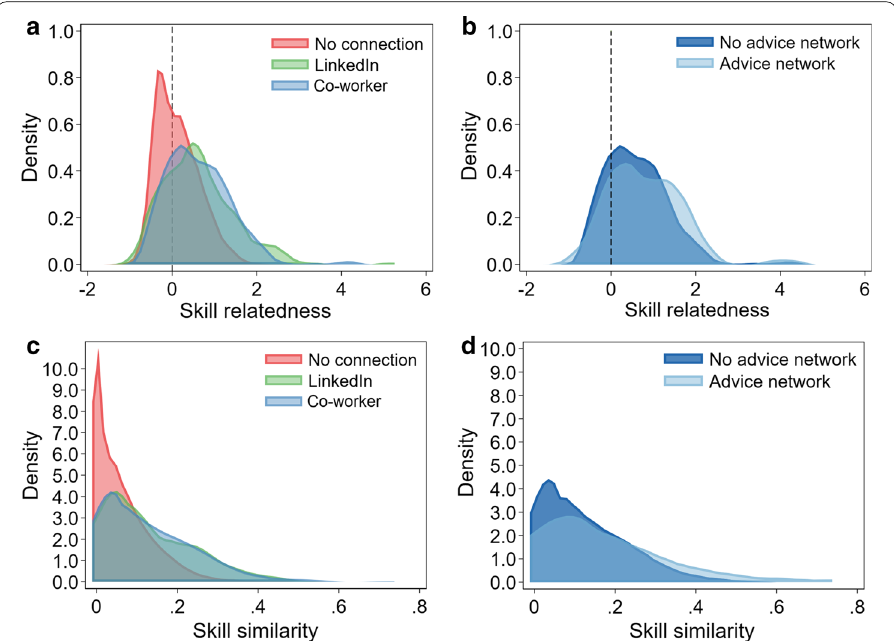
Fig. 4 Average relatedness ( a , b ) and similarity ( c , d ) of skills between pairs of respondents. a , c Comparison of LinkedIn connections (green)|Co-workers in firms (blue)|None (red). b , d Co-workers in the firms connected in advice network (light blue)|Not connected in advice network (dark blue). Indicates increased skill similarity and relatedness if employees work at the same firm or are connected on LinkedIn, and especially if they ask each other for